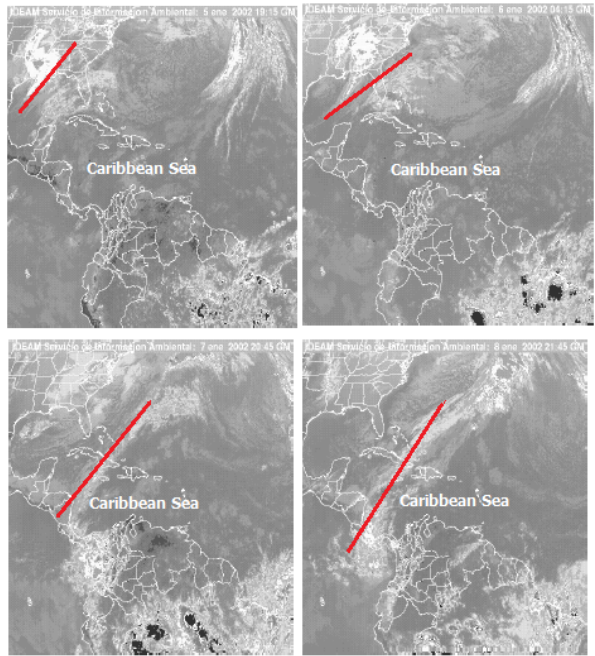
Fig. 3. Cold fronts in the Caribbean Sea in January 2002 (Narváez and León, 2003 and modified by the authors).